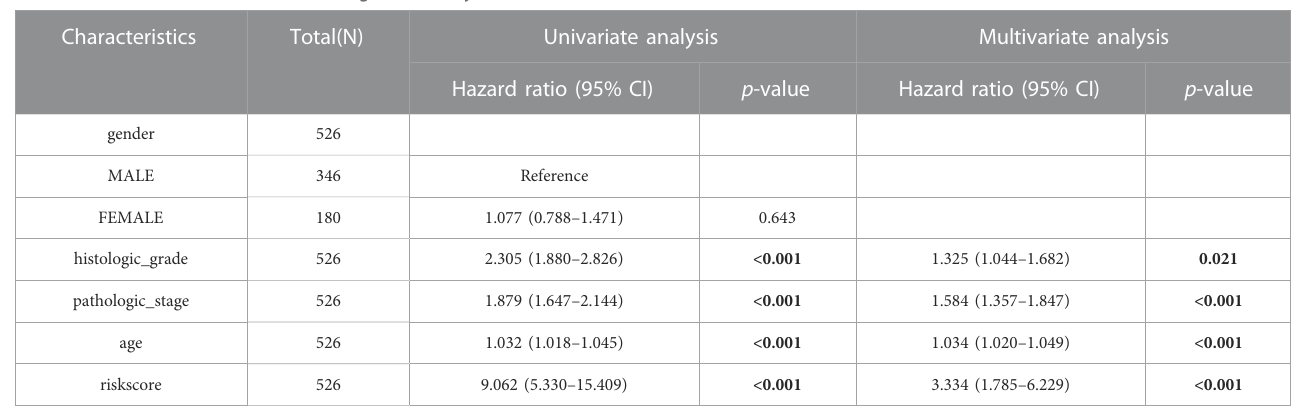
TABLE 1 Univariate and multivariate Cox regression